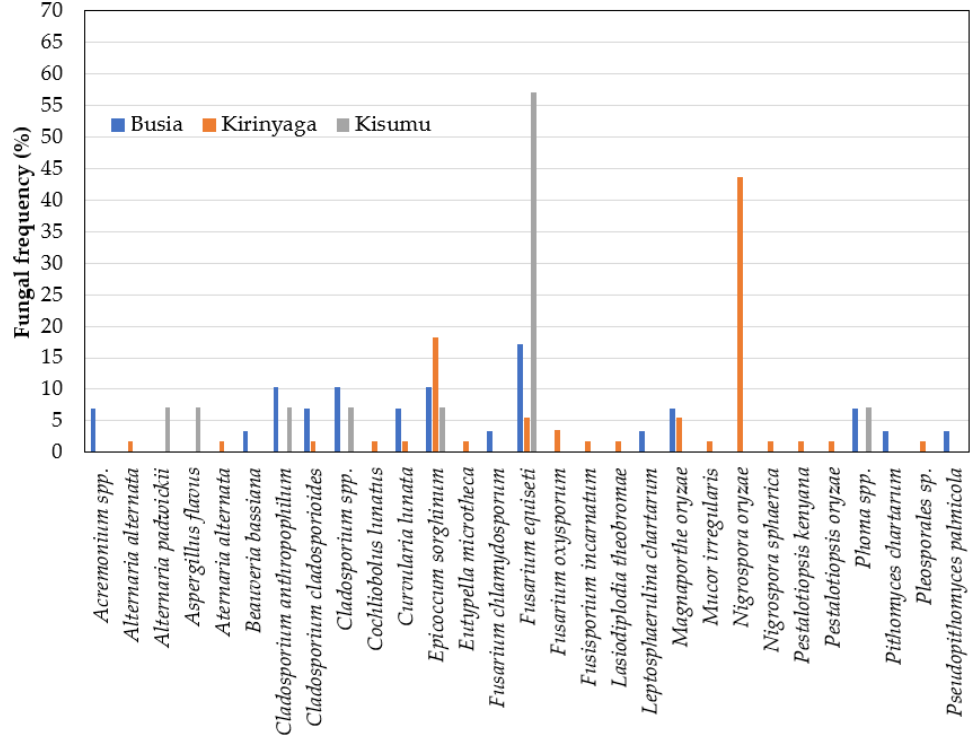
Figure 6. Occurrence of fungal species in neck tissues of rice from Busia, Kirinyaga, and Kisumu counties of Kenya surveyed in 2019. The frequencies of the most abundant fungal species were analyzed in the leaf and neck tissues. The most frequent fungal species in the rice leaves were in the following order of occurrence: N. oryzae (68% Kirinyaga), F. equiseti (23% Kisumu; 2% Kirinyaga), E. sorghinum (20% Busia; 17% Kirinyaga), and C. miyabeanus (12% Kisumu; 10% Busia). For the neck tissues, the most prevalent fungal species were as follows: F. equiseti (58% Ki- sumu; 17% Busia and 6% Kirinyaga), N. oryzae (43% Kirinyaga), and E. sorghinum (17% Kirinyaga; 11% Busia and 7% Kisumu). The fungal species that were isolated in both the leaves and the neck tissue were: Cladosporium cladosporioides , E. sorghinum , F. equiseti , F. oxysporum , N. oryzae , N. sphaerica , and Pithomyces chartarum (Figures 5 and 6). Owing to the high frequency of N. oryzae in the samples that originated from farmers who had complained of a blast-like epidemic in their fields, we conducted further analysis to gain insights as to whether the isolates were clones or diverse strains. The sequences of these isolates were aligned, and a neighbor-joining phylogenetic tree was generated based on Kimura’s two-parameter estimate model in CLC Genomics Workbench [23]. A com- parison of the percentages of the nucleotide similarities showed that 92% of the sequences of the isolates were 100% similar, with the similarity in the rest ranging from 94% to 99.99% (Supplemental Figure S1). Our efforts to induce sporulation were unsuccessful and, therefore, we did not confirm the cause of the blast-like symptoms using classical Koch’s postulates.